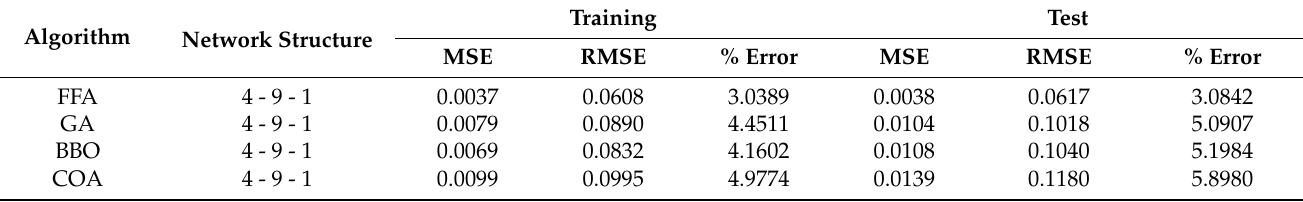
Figure 15. R 2 score versus number of neurons in the hidden layer for ( a ) firefly algorithm, ( b ) genetic algorithm, ( c ) biogeography-based algorithm and ( d ) Cuckoo algorithm. Table 4. Evaluating results for the prediction of chromium